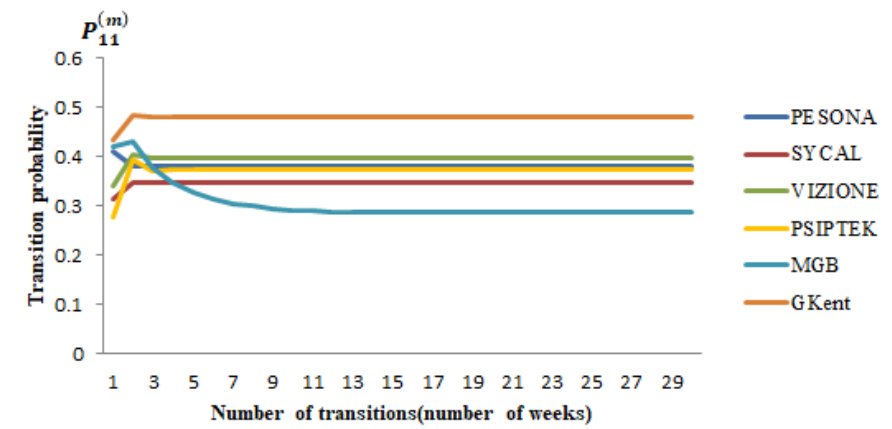
Figure 2. The m-step transition probabilities for share price increases